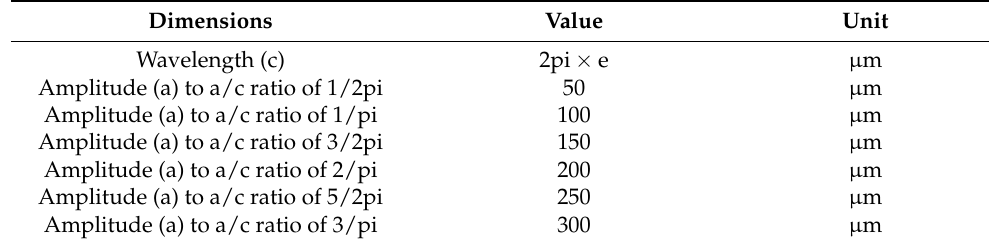
Figure 1. The schematic diagram of the proposed micromixers: ( a ) the passive micromixer design, ( b ) the distribution of electrodes in the active electroosmotic micromixer. Table 1. Dimensions for the proposed micromixers.